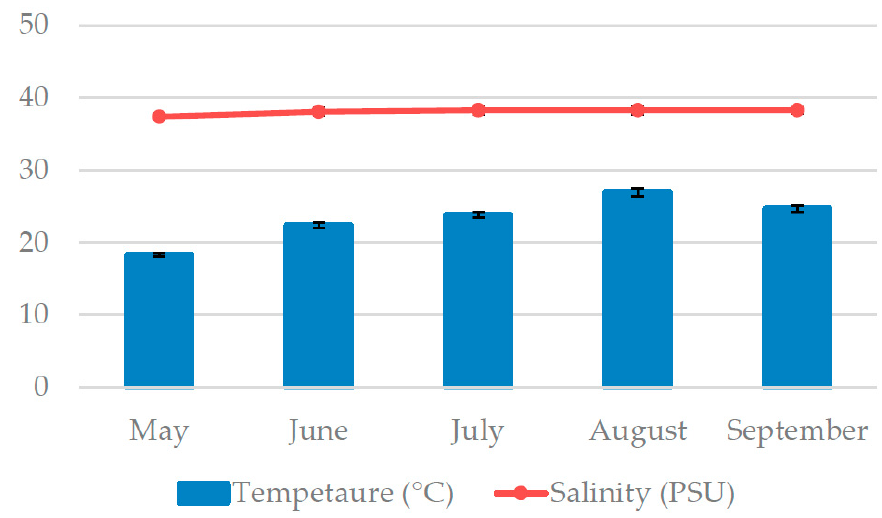
Figure 1. Sea temperature and salinity measured during harvesting of P. pavonica .